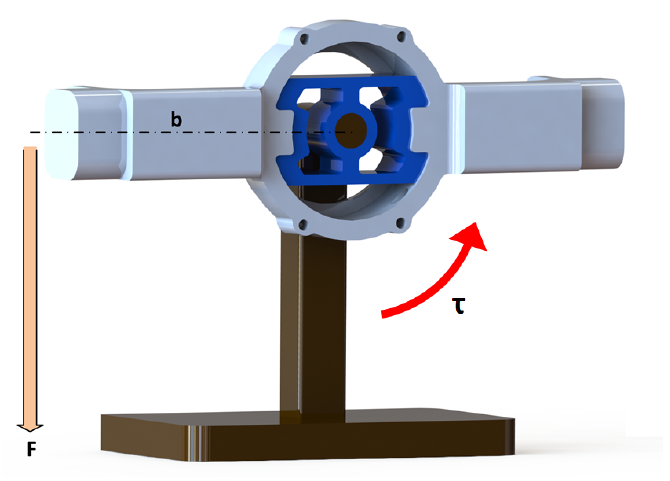
Figure 18. Experimental set up layout, the clockwise/counter clockwise torque τ is generated about sensor by inserting force F at a perpendicular distance b at the right or left end of the beam.